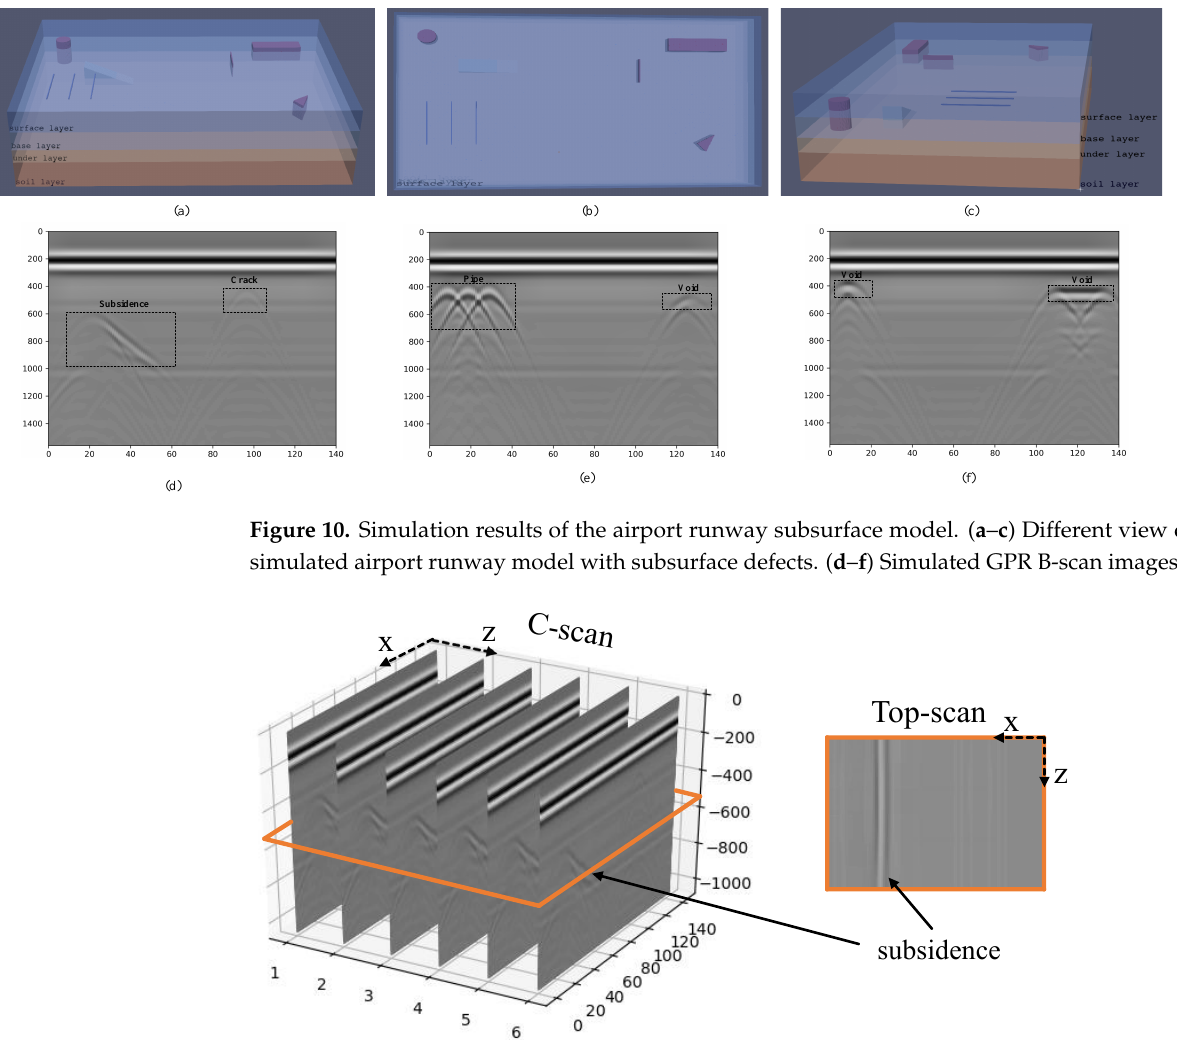
Figure 11. Generated C-scan data and Top-scan image based on simulated B-scan